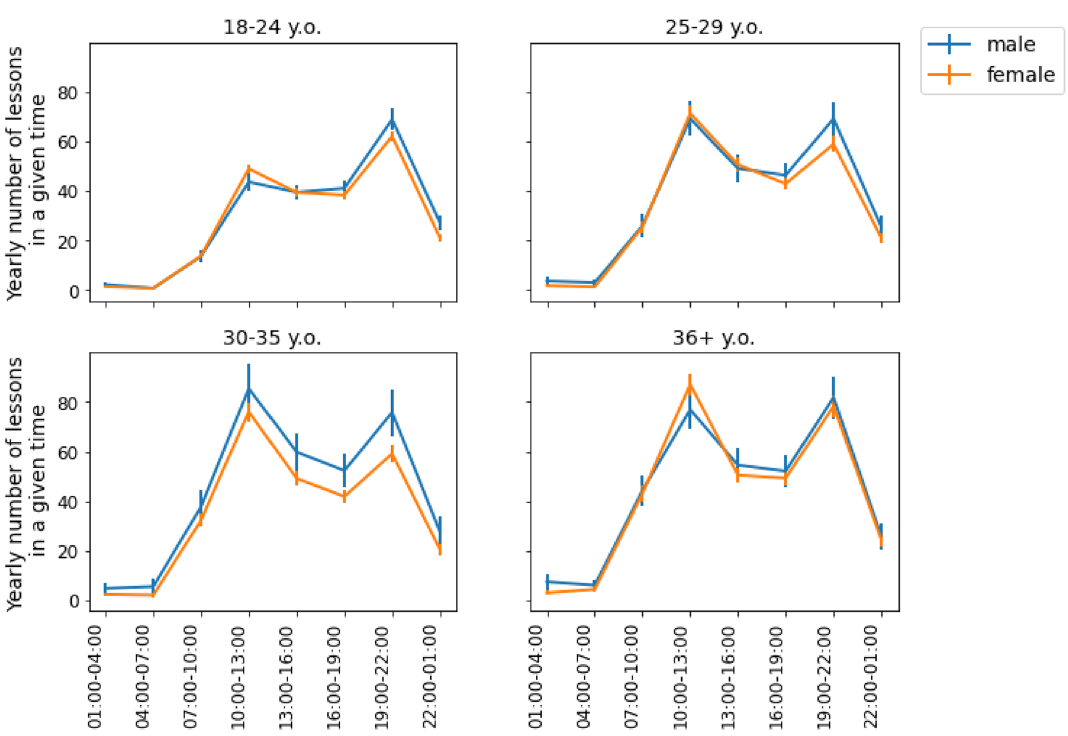
Figure 6. Average yearly teaching workload in 2020 for four different age categories. Vertical bars correspond to 95% confidence intervals. Skyeng’s male teachers had a higher workload than female teachers notably in three age groups: 18–24, 25–29, and